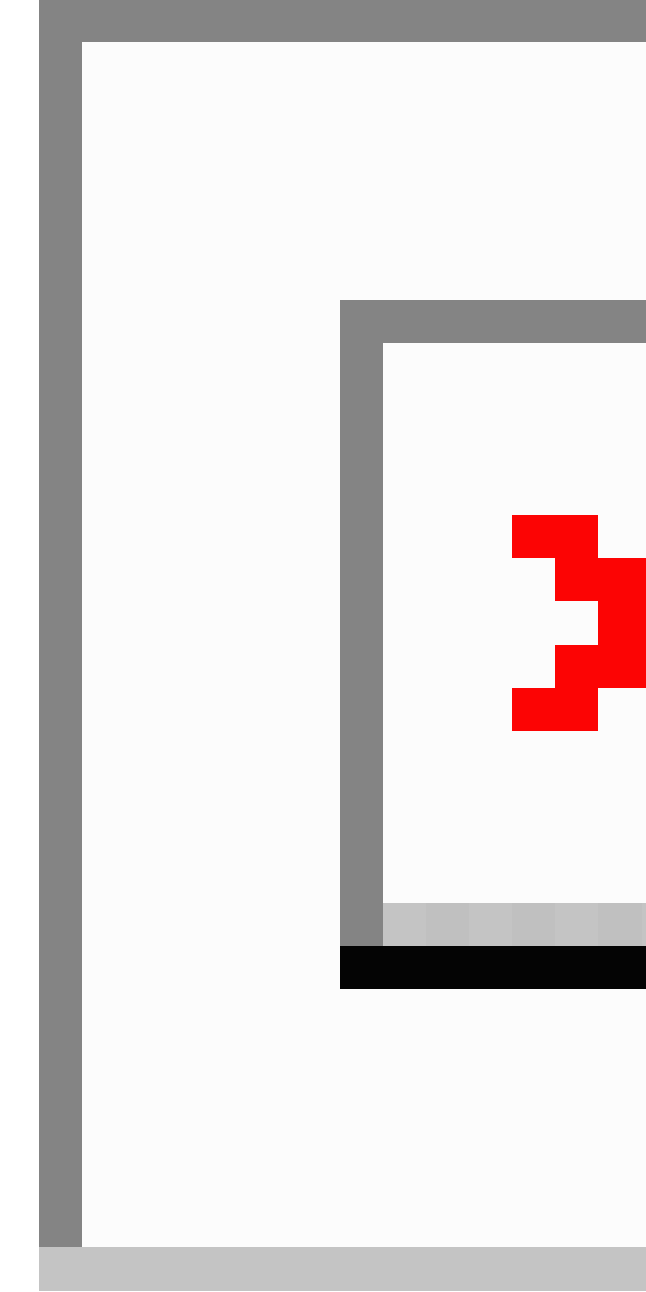
Figure 3. Weekly exercise performance by exercise